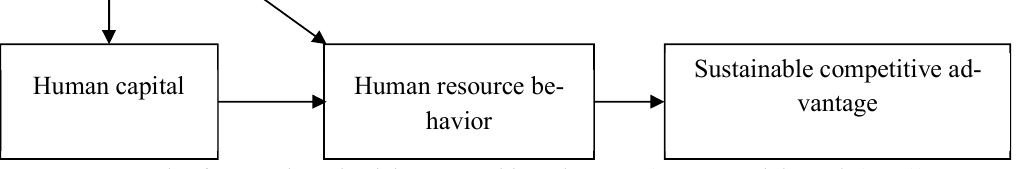
Fig. 1. Role of HRMP in maintaining competitive advantage (Source: Wright et al.